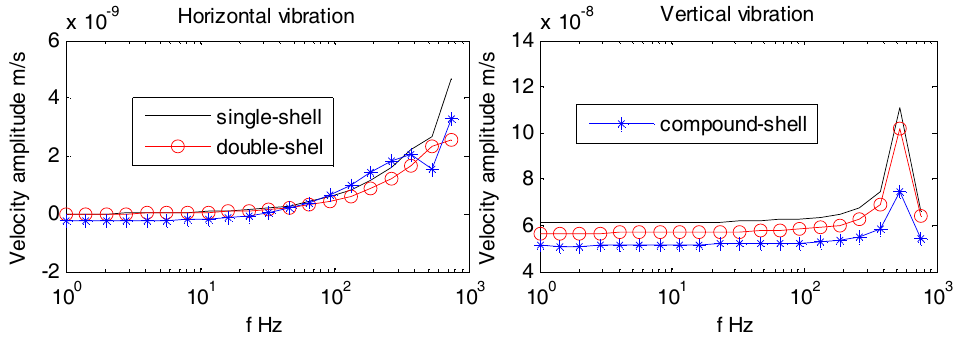
Figure 32. Vibration velocity amplitudes of the OBSs with various casings under incident angle of 90°.